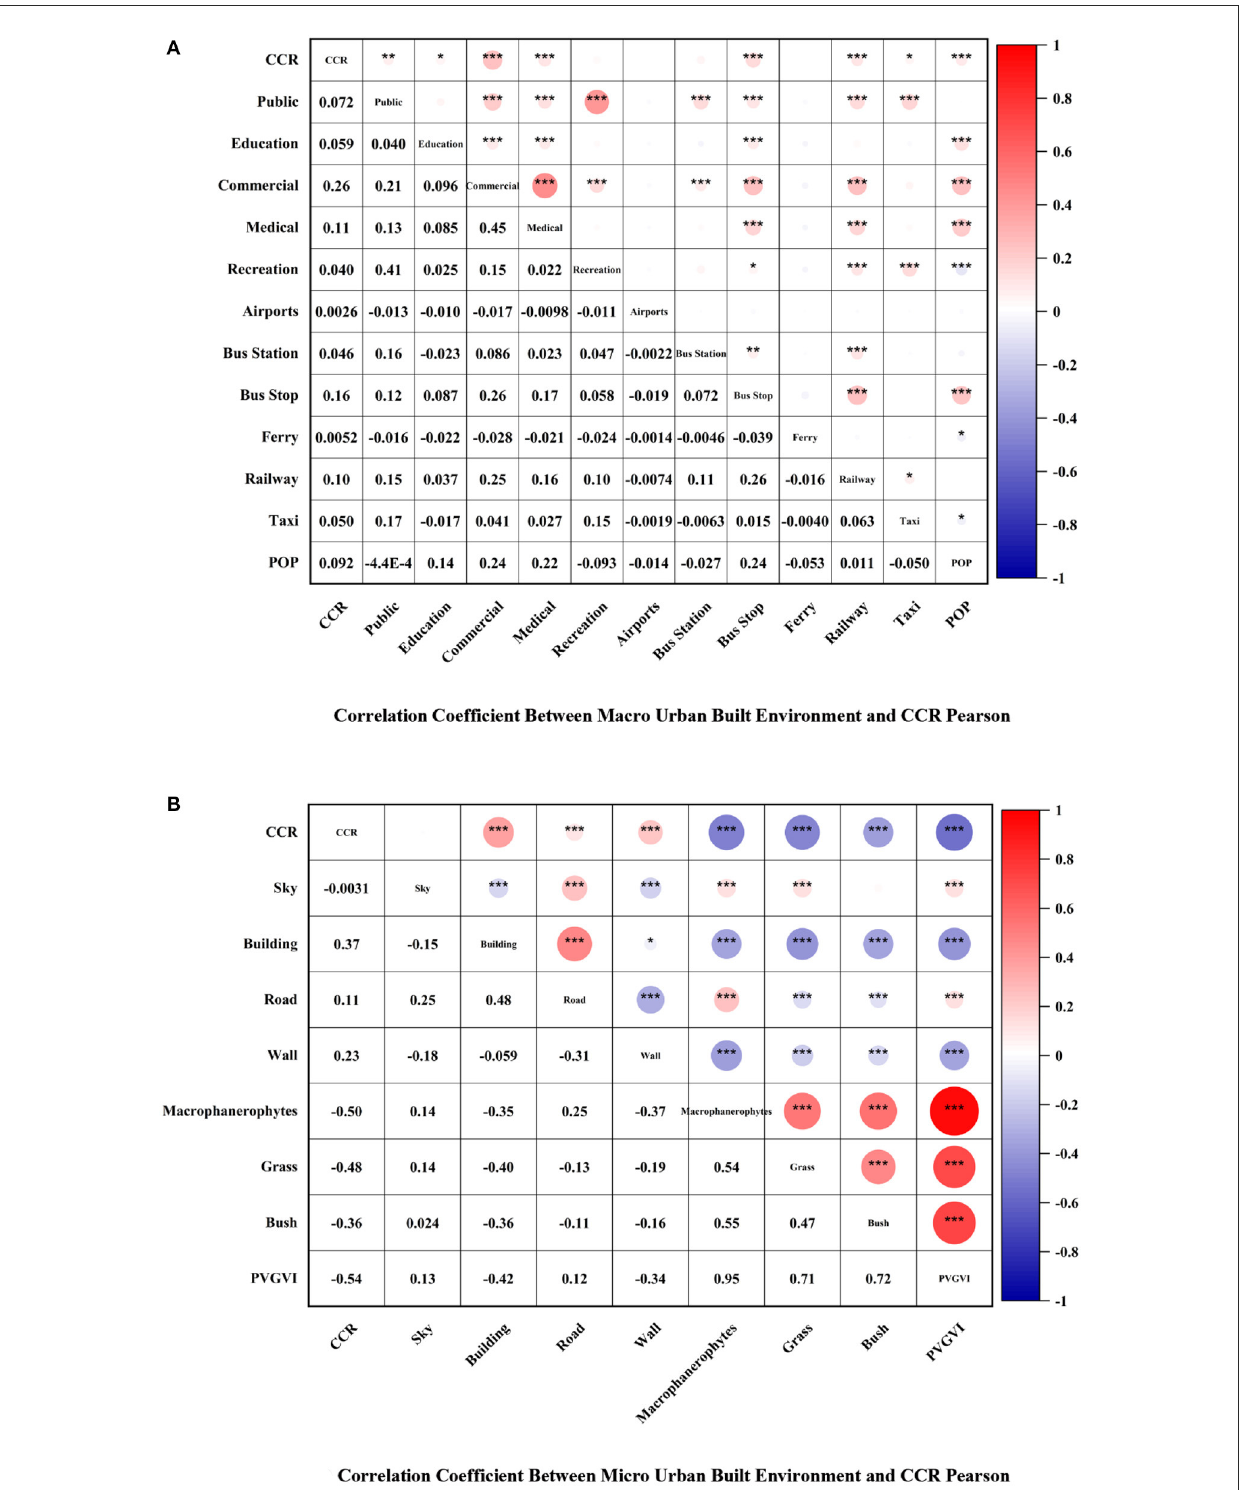
FIGURE7 Correlation coefficient between urban built environment and CCR Pearson. (A) Correlation coefficient between macro urban built environment and CCR Pearson. (B) Correlation coefficient between micro urban built environment and CCR Pearson. * p < 0.05, ** p < 0.01, *** p <